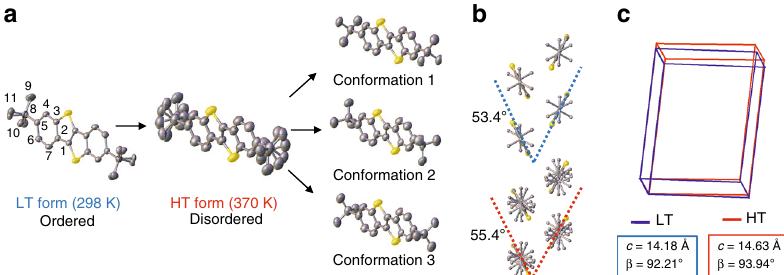
Fig. 2 Molecular structure differences between the LT and the HT polymorphs in ditBu-BTBT. a Order-to-disorder transition of the side chain and the three conformations determined from SCXRD. The carbon atoms in the asymmetric unit are labeled. b Change in herringbone dihedral angle between the LT and HT polymorphs. c Comparison of unit cells before and after the transition. The unit cell parameters with the most pronounced changes are labeled. Hydrogen atoms are omitted for